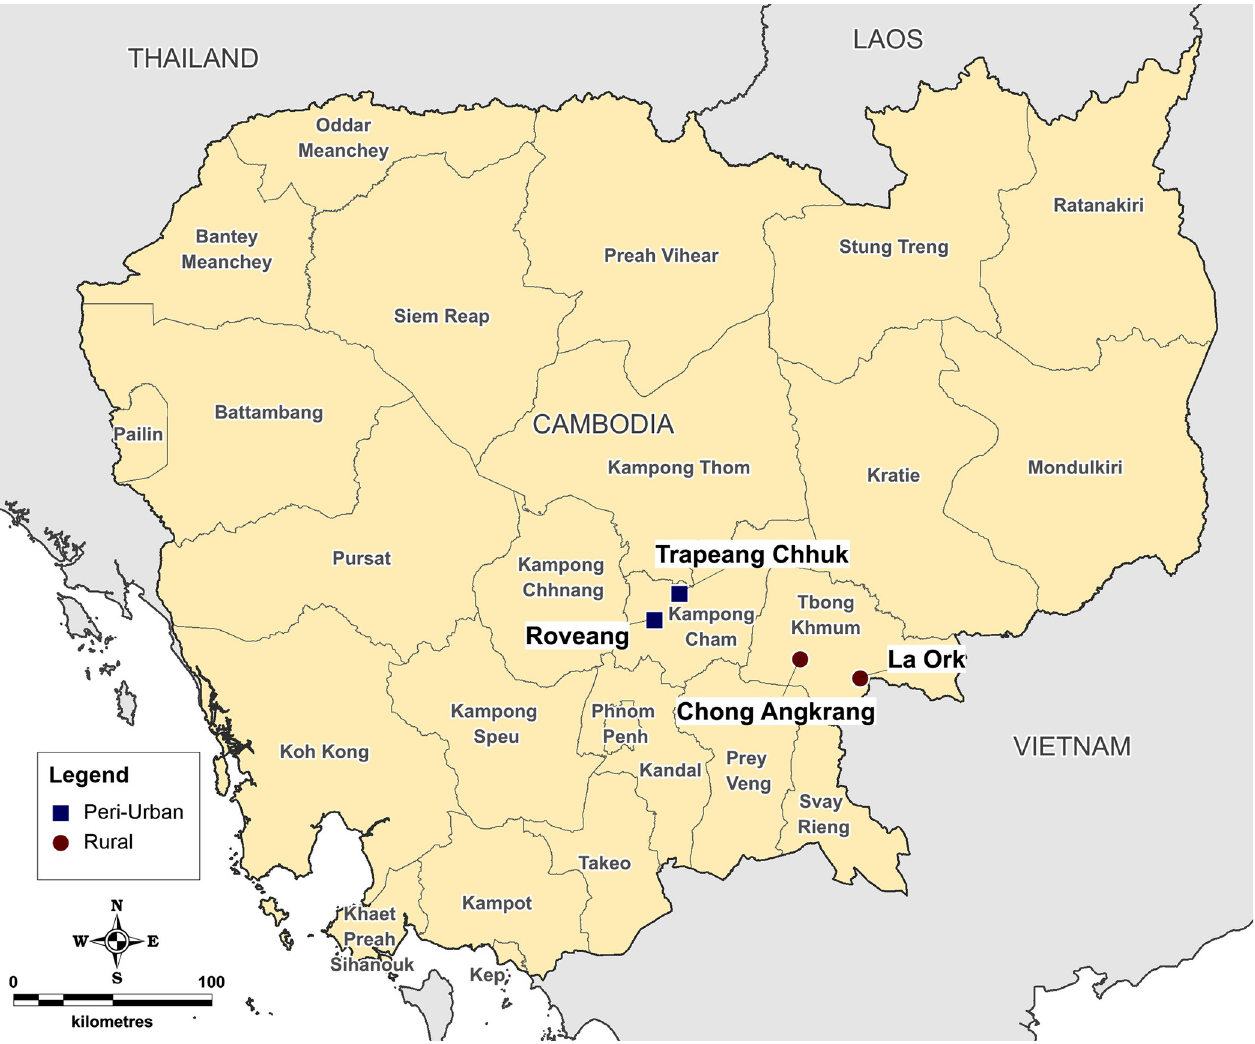
Fig 1. Study site location map. Custom map produced by the authors using MapInfo Professional v15.0.2 (Pitney Bowes Software Inc. 2015, Stamford, CT; https://www.pitneybowes.com) geographic information system mapping software. Site location data were acquired by the study team using global positioning system (GPS). Baseline spatial data were obtained from the GADM database of Global Administrative Areas (https://gadm.org) under a CC-BY 4.0 license